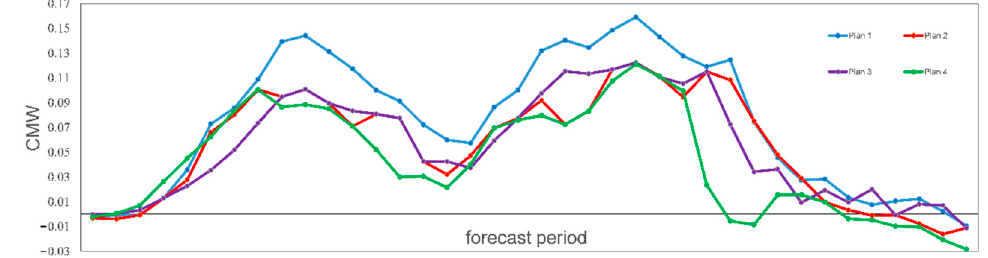
Figure 6. Verification of hourly precipitation forecast by using CMW method in the next six hours.